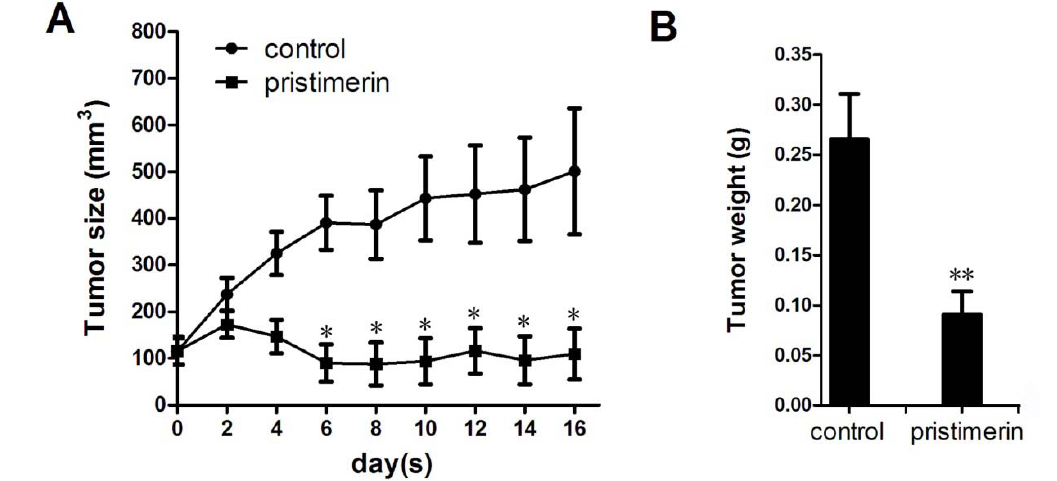
pristimerin inhibited tumor angiogenesis (magnification, ×200). Arrows, blood vessels. Columns, mean; bars, SD. * p < 0.05 or ** p < 0.01 versus